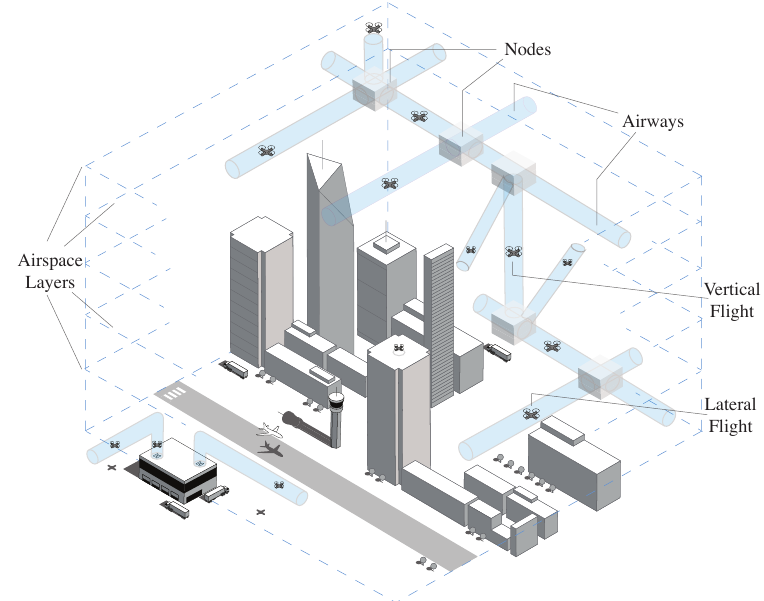
Figure 3. Proposed multilayer UTM model of the Class G airspace [22].